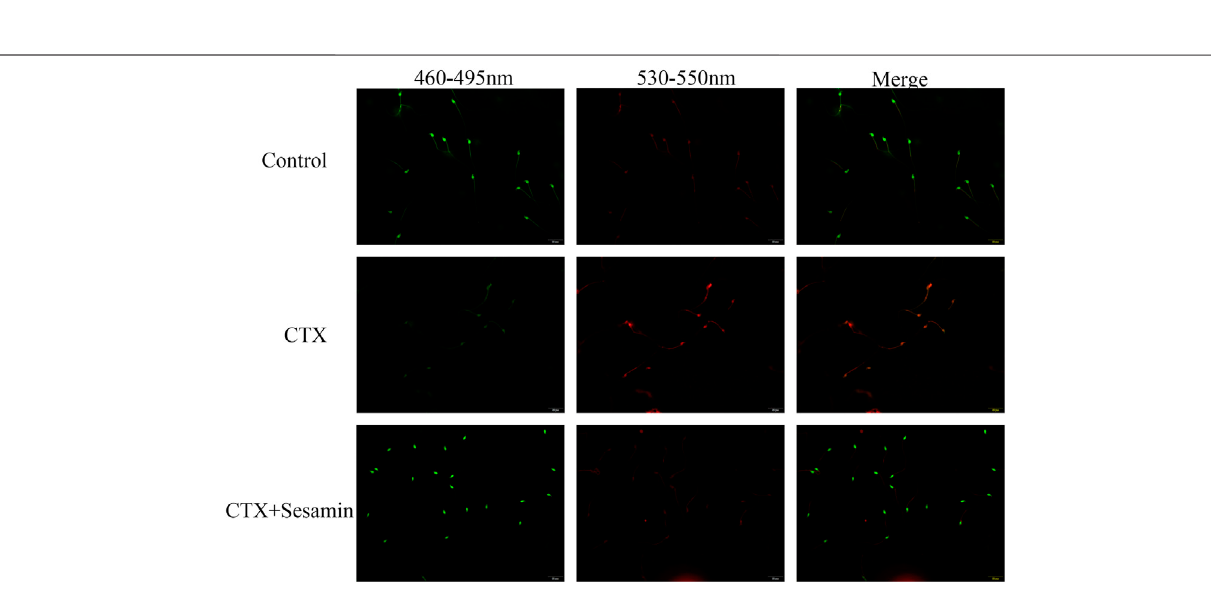
Frontiers in Pharmacology |